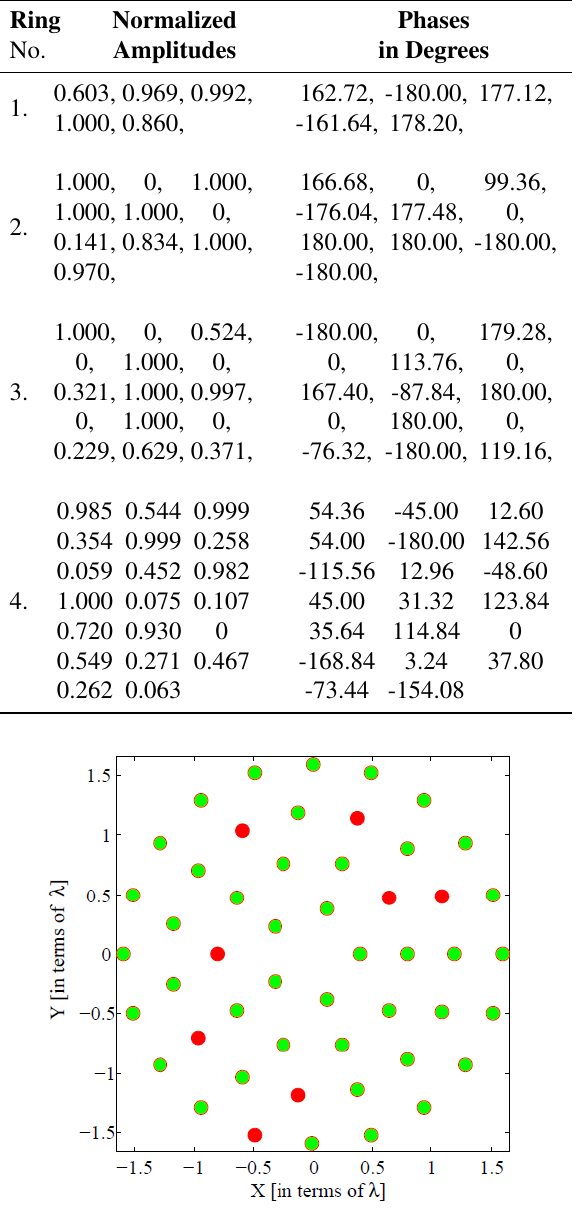
Table 3: Amplitudes and Phases of the Array Elements Ring